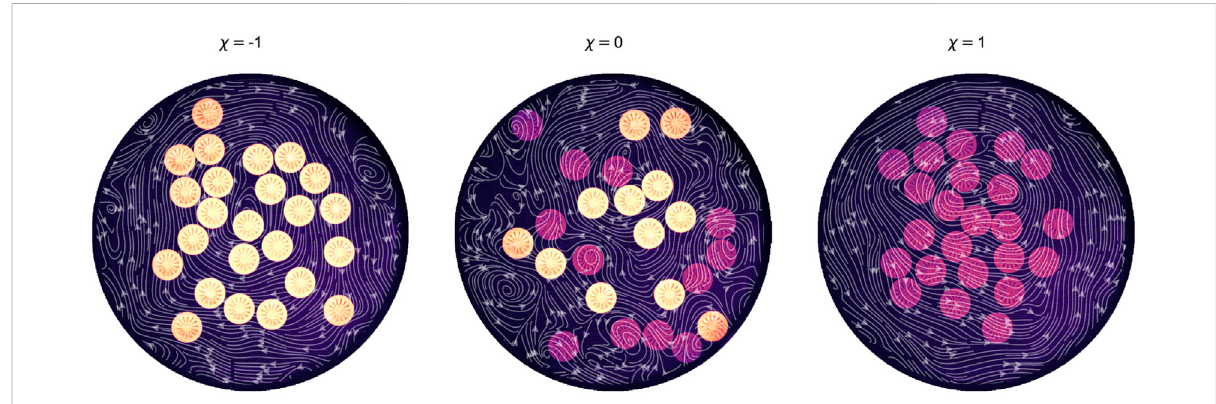
FIGURE 2 Stream lines of the fl ow fi eld obtained for three experiments with a low energy input, at χ = − 1, T t (cid:2) 0 . 84 m p ( σ /s ) 2 (left), χ = 0, T t (cid:2) 0 . 66 m p ( σ /s ) 2 , (center), χ = 1, T t (cid:2) 0 . 25 m p ( σ /s ) 2 . Left and right panels correspond to the C + phase and the central experiment to the complex chiral phase C ± (right).